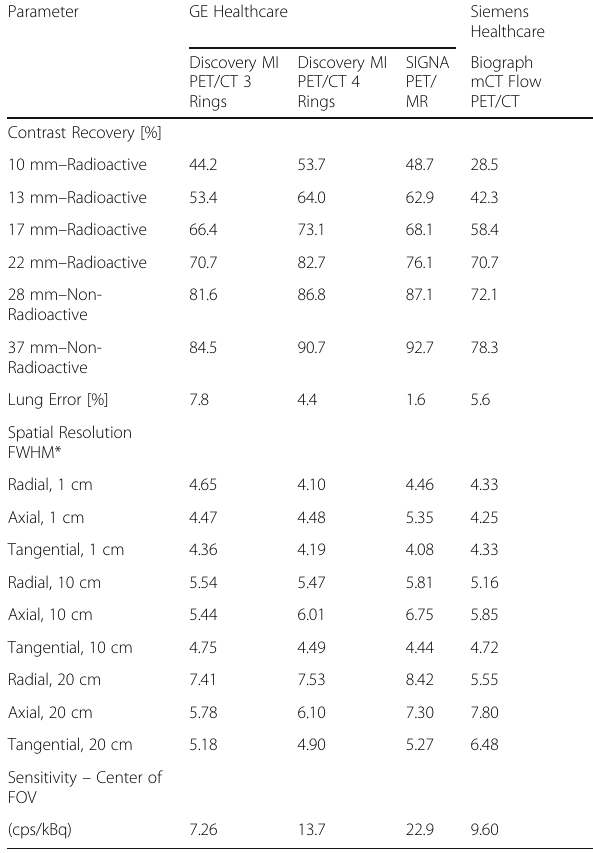
Table 1 (abstract A29). Shows the image quality, spatial resolution and sensitivity results for both institutions